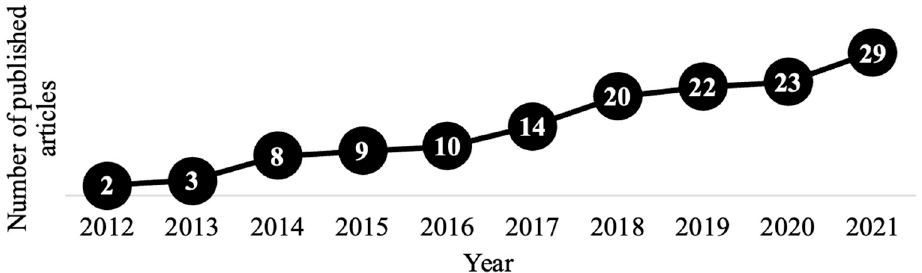
Figure 2. AI applied to FM in the BIM context reviewed papers published over the last decade (2012–2021).